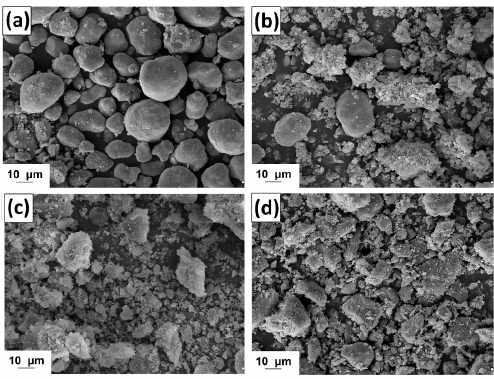
Figure 9. SEM images of manganese oxide ( a ) and MnO 2 /lignin hybrid materials based on biopolymer activated by using [C 4 im][HSO 4 ] ( b ), [Et 3 NH][HSO 4 ] ( c ) and [C 4 C 1 im][MeSO 3 ] ( d ).